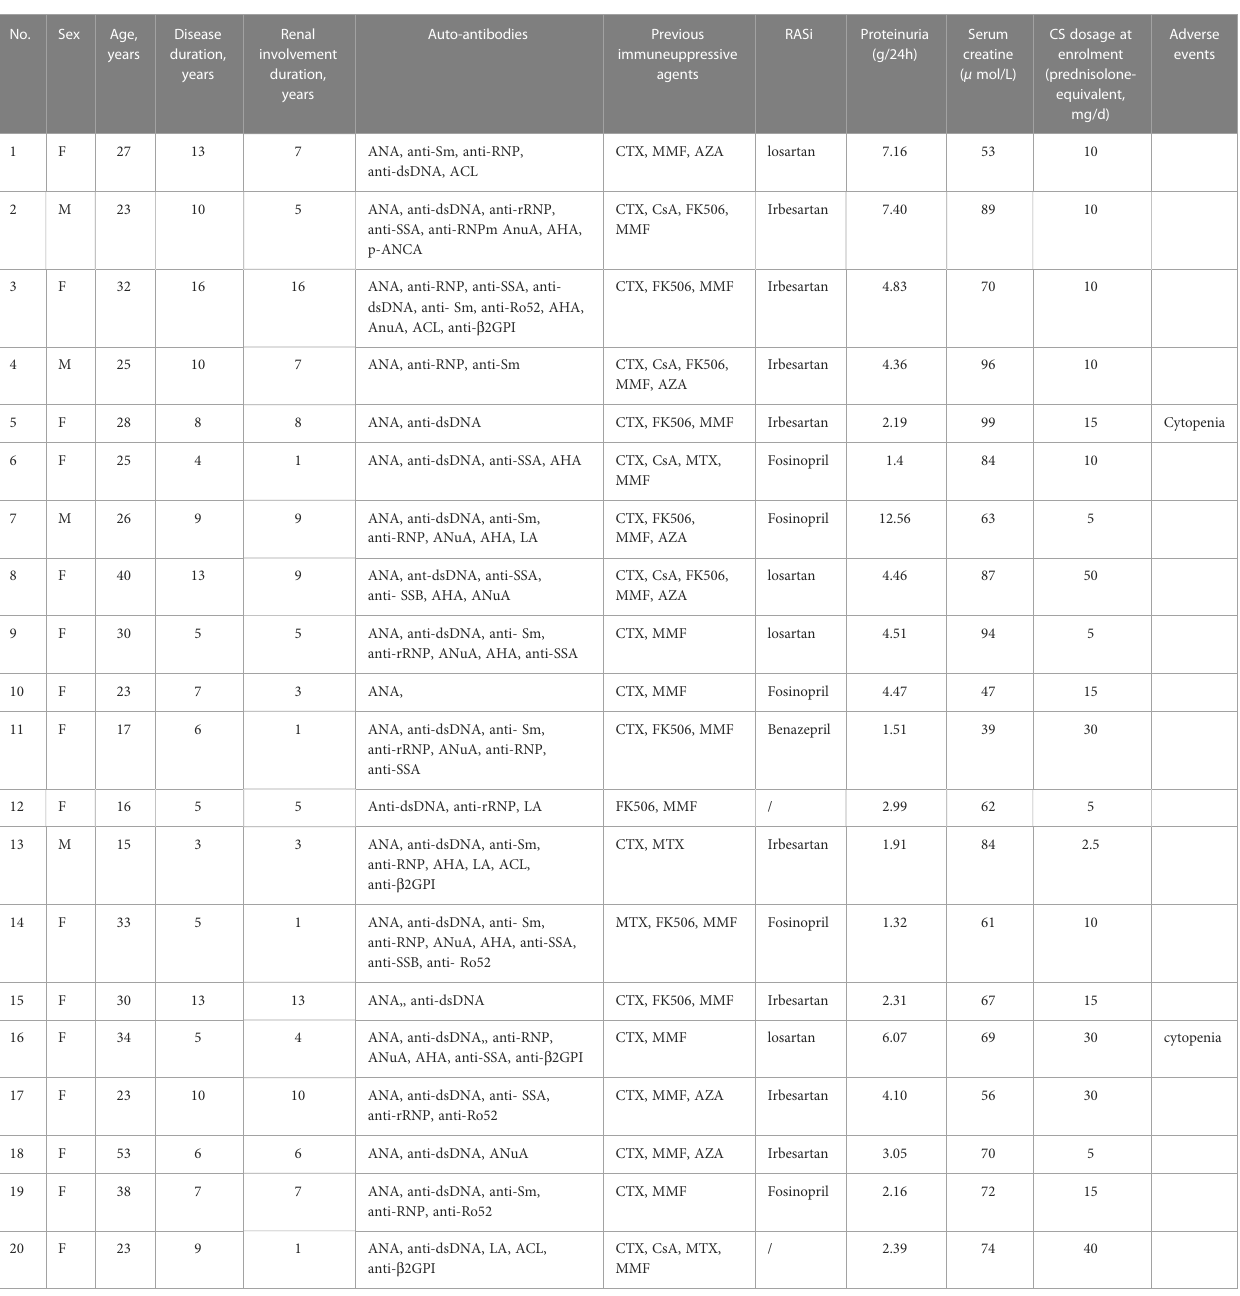
TABLE 1 Basic characteristics and adverse events of LEF for refractory LN.